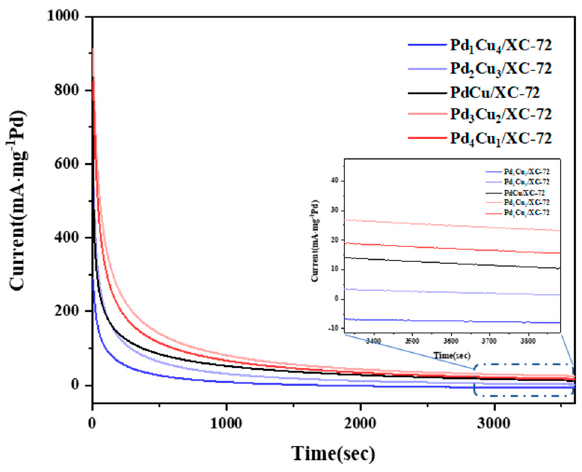
Figure 8. CAs in 1.0 M KOH + 1.0 M CH 3 OH − purged N 2 at 50 mVs −